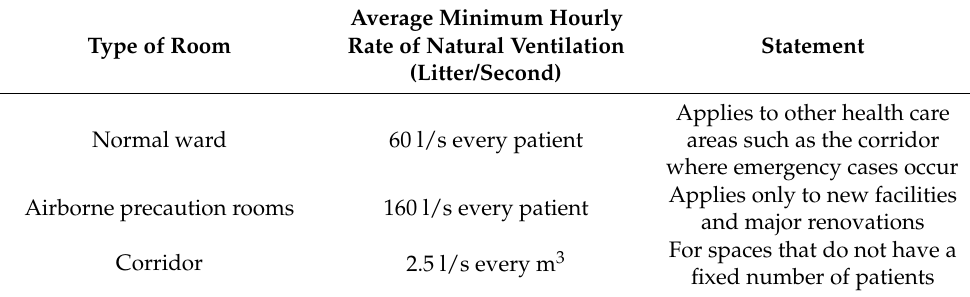
Table 1. Minimum rate of natural ventilation according to WHO guidelines [28].